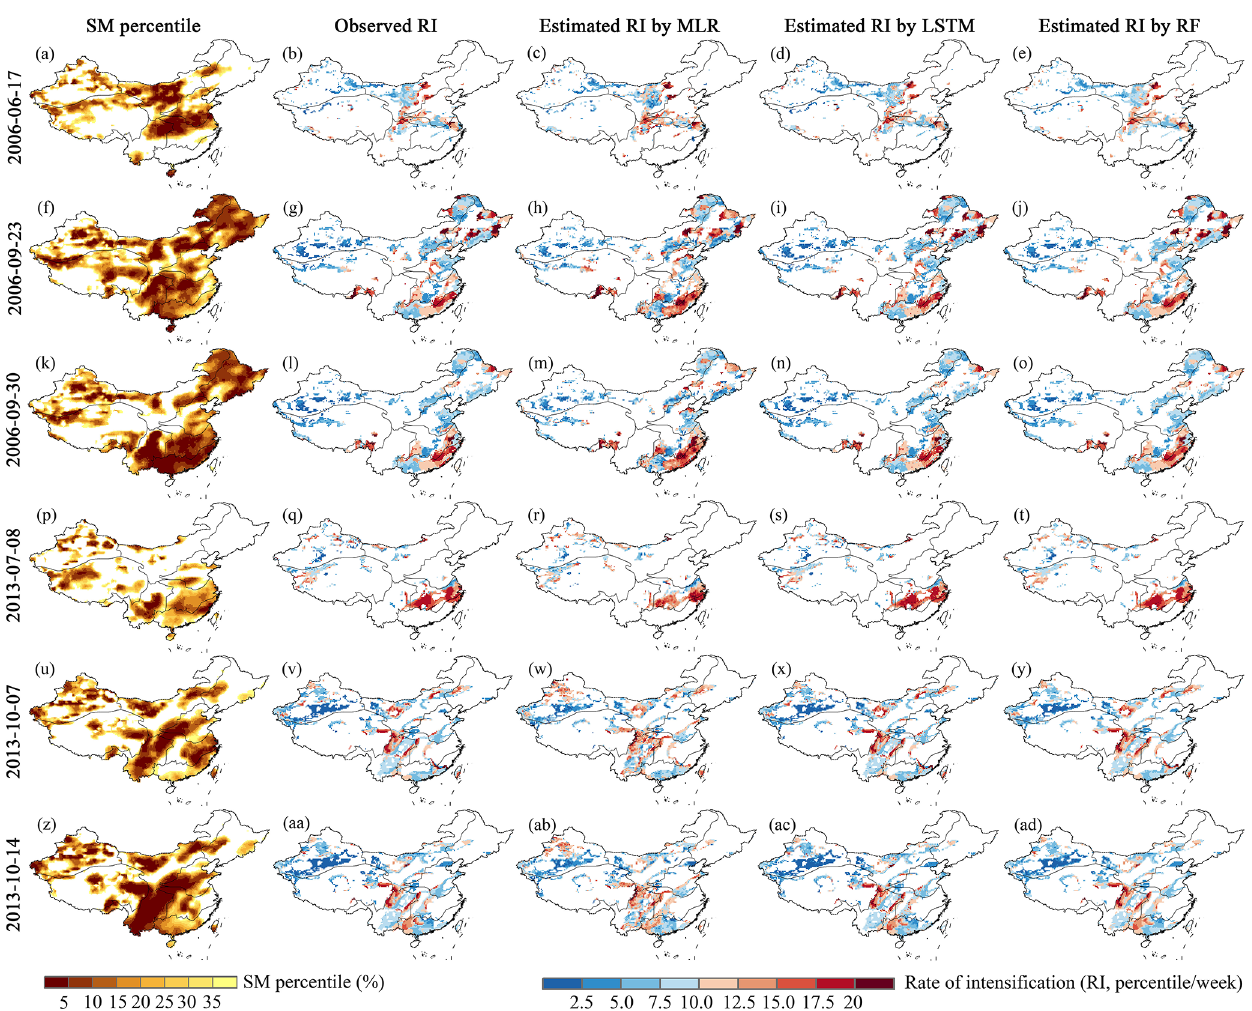
Figure 10. Spatial evolution of the weekly soil moisture percentile, the observed RI, and estimated RI from MLR, LSTM, and RF models over the study area in summer and autumn of 2006 and